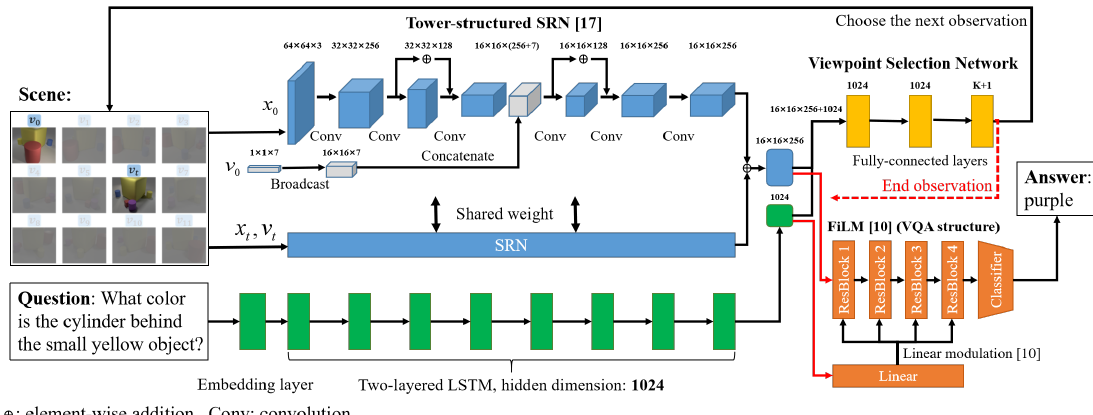
Figure 3. Detailed network structure. Our overall framework is composed of a tower-structured SRN [17] (shown in blue), a viewpoint selection network (shown in yellow), and a VQA framework (shown in orange), which is modified from FiLM [10]. The viewpoint selection network and VQA share the question feature extraction structure (shown in green). Based on the previous observation, the viewpoint selection network chooses the next observation or ends observation (red dotted arrow flow). While the end observation is chosen, the scene representation to that time step, and the question feature (red arrow flows) will be processed by the VQA framework to give an answer